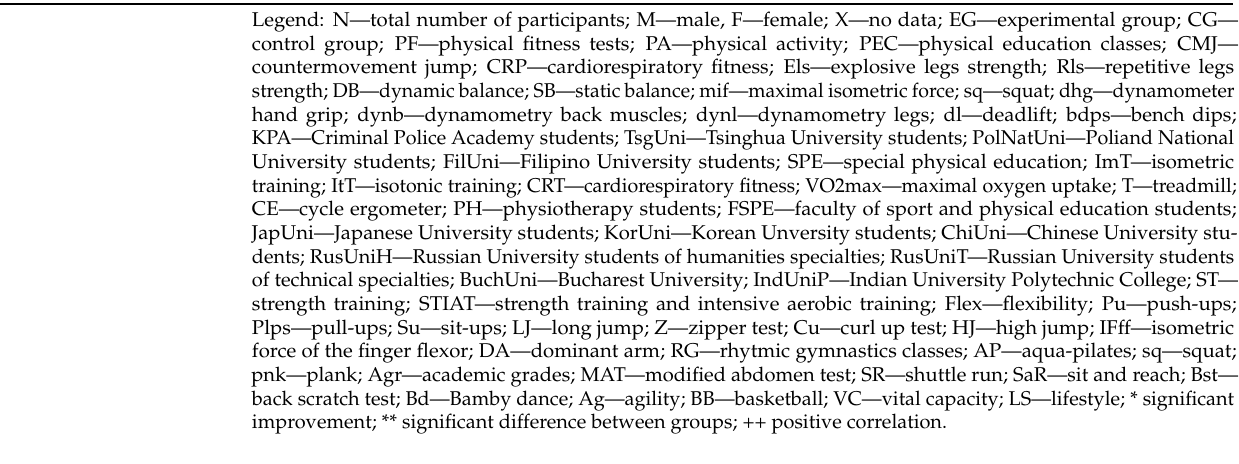
Table 3. Physical activity